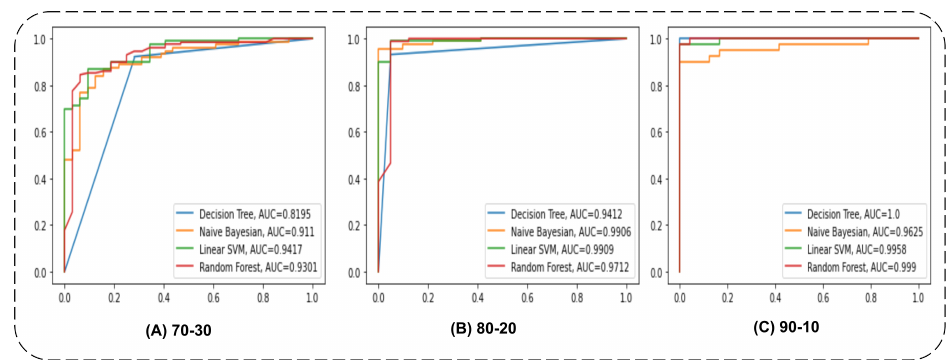
Figure 2. ML classifiers—area under the curve (AUC) for all three splits applied in the proposed